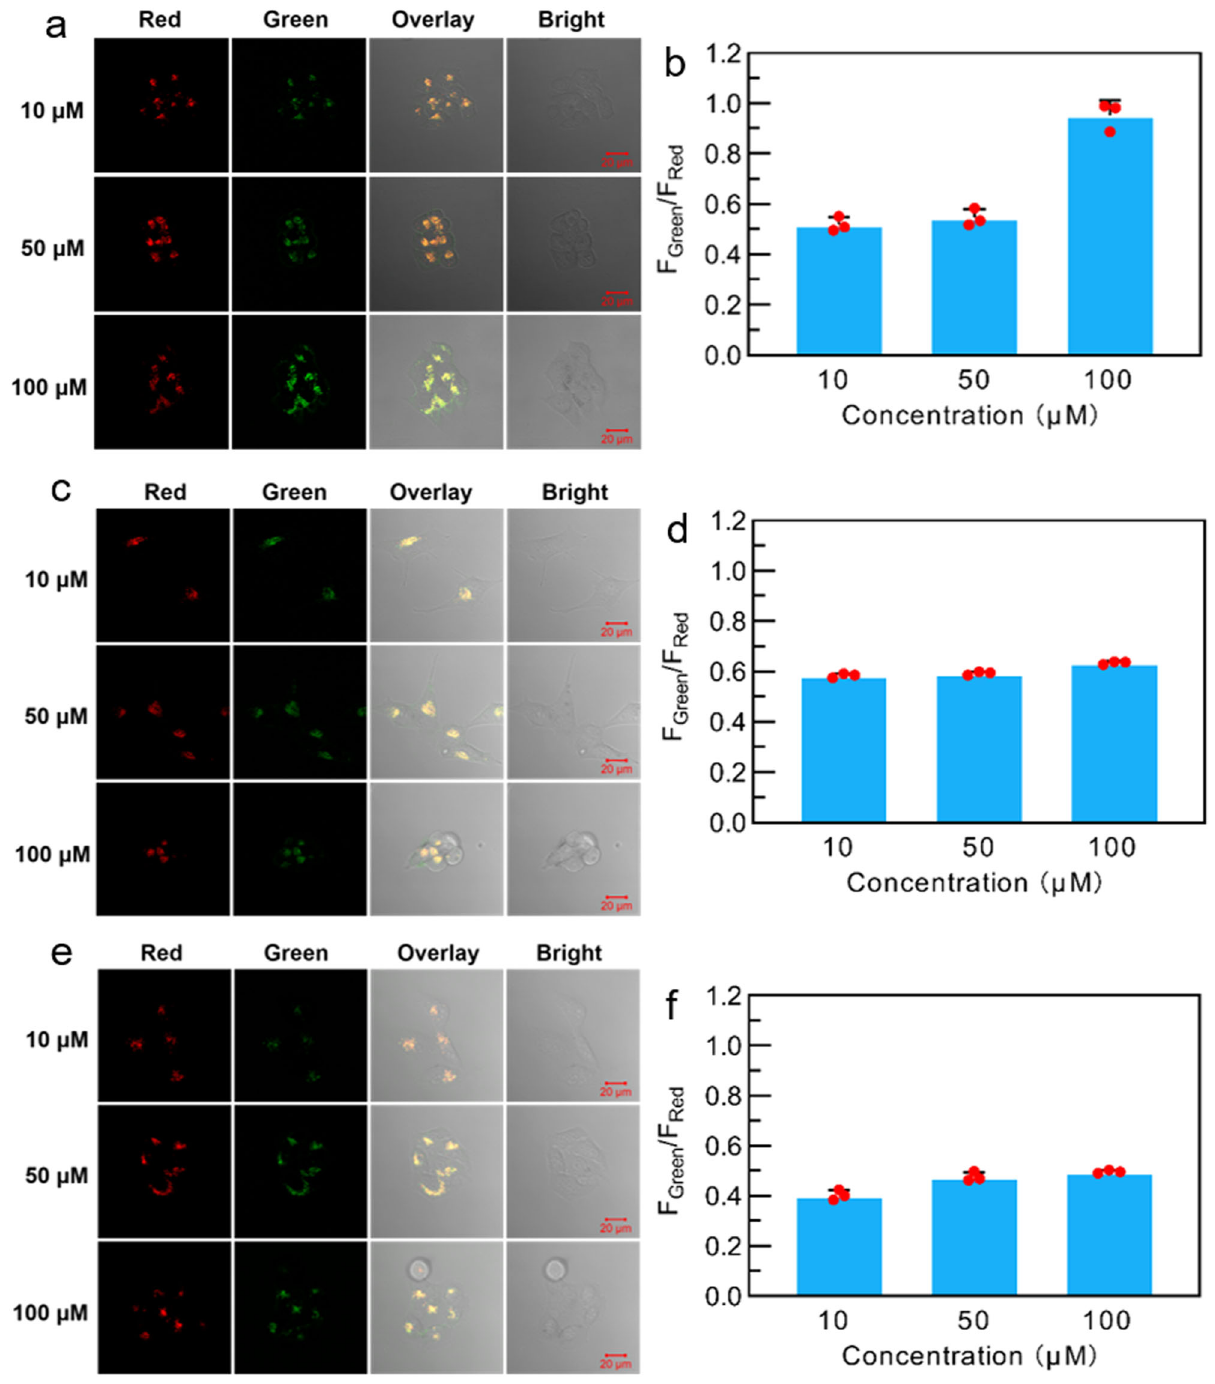
Fig. 6 Concentration-dependent ratiometric fl uorescence bioimaging. CLSM images and F green / F red values of ( a , b ) HeLa, ( c , d ) MCF-7, and ( e , f ) cells stained with PPAB-PyS NPs (10, 50, 100 μ M) for 24